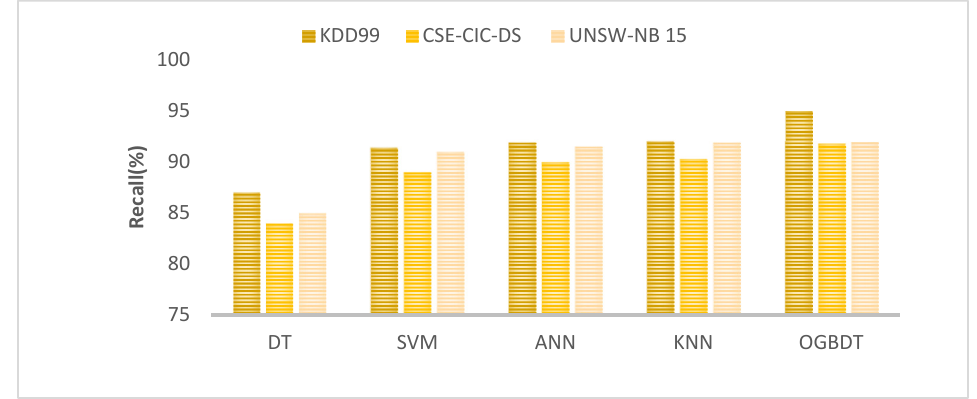
Figure 5. Recall rate comparison.